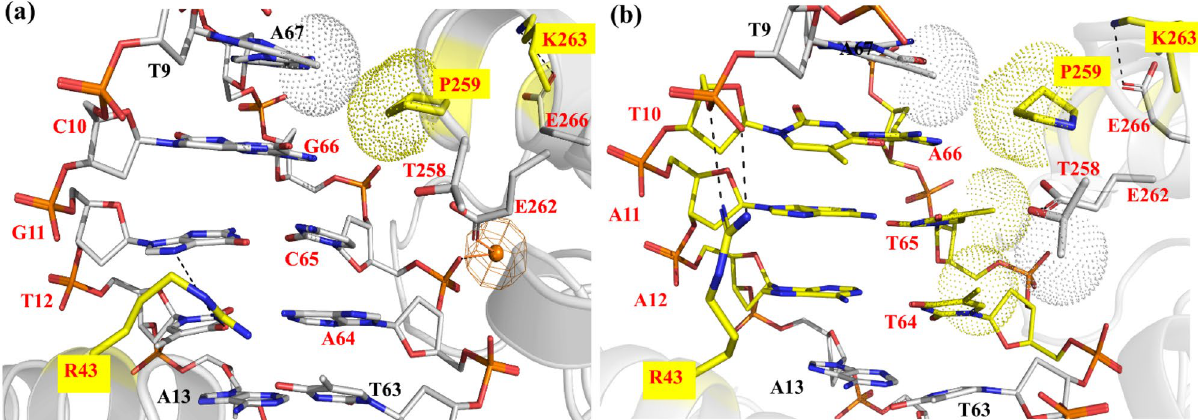
Figure 4. Detailed view of interactions observed in the ( a ) mCre K / loxP complex and ( b ) mCre K / rox complex at the PDI BJ area based on MD simulations. The mutated amino acids with respect to wild type Cre are labeled with a yellow box. The hydrogen bonds are shown in black dashed lines and the van der Waals interactions in dotted spheres. A predicted water position using WaterMap (version 1.0, https ://www.schro dinge r.com/) is represented by an orange sphere and its interactions in solid orange lines. Pymol was used to generate the image (version 2.1, https ://pymol